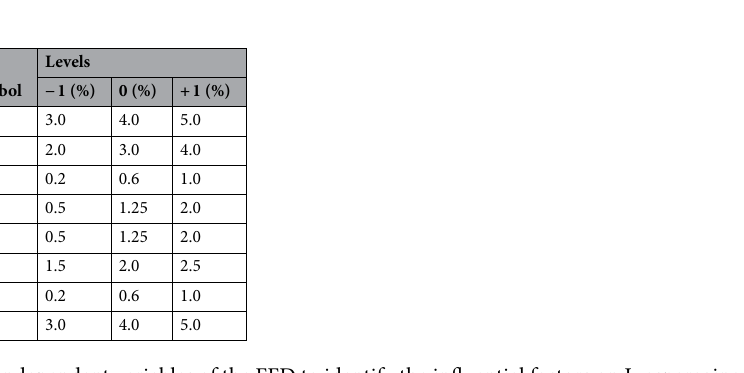
Table 6. Levels of the independent variables of the FFD to identify the influential factors on L-asparaginase production.